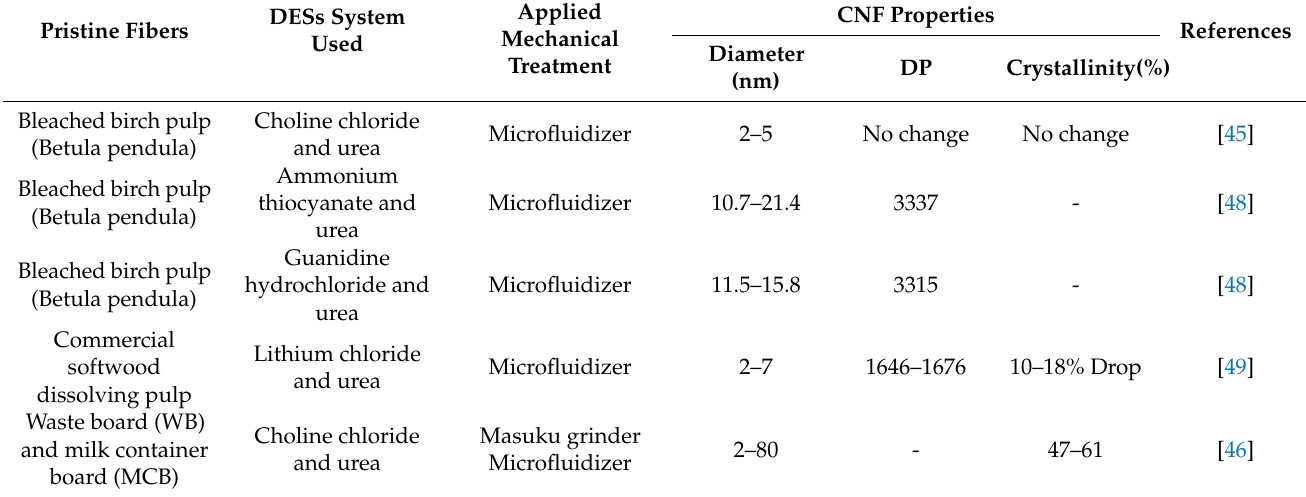
Table 6. Different DESs used for the pretreatment of cellulose and corresponding CNF characteristics. Pristine